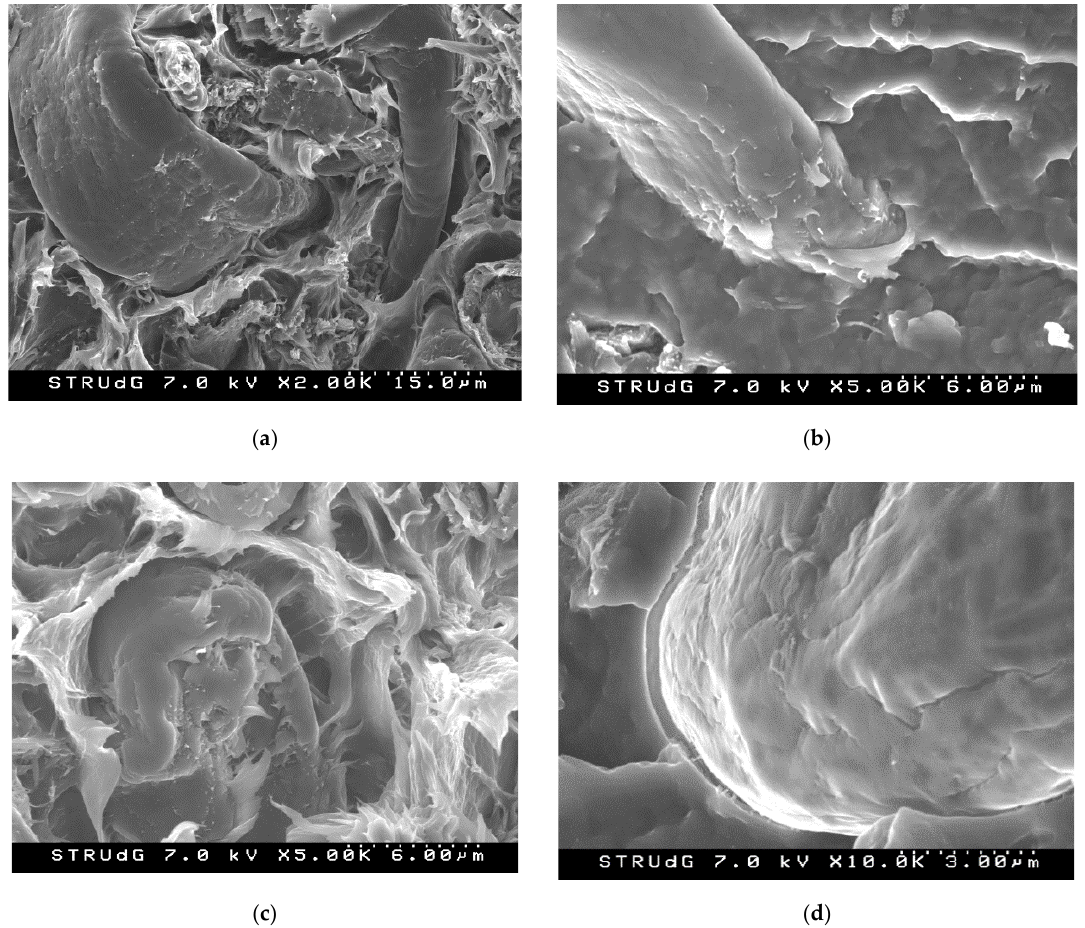
Figure 11. SEM micrographs of fracture surfaces of 25% cellulose pulp composite tested under tensile load at different magnification levels.